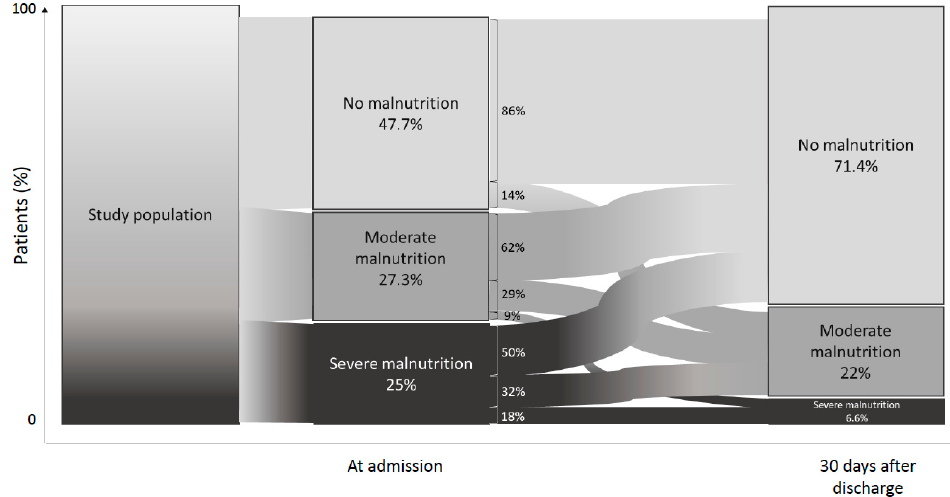
Figure 3. Evolution of nutritional status according to GLIM criteria between admission and 30 days after hospital discharge in COVID-19 patients.